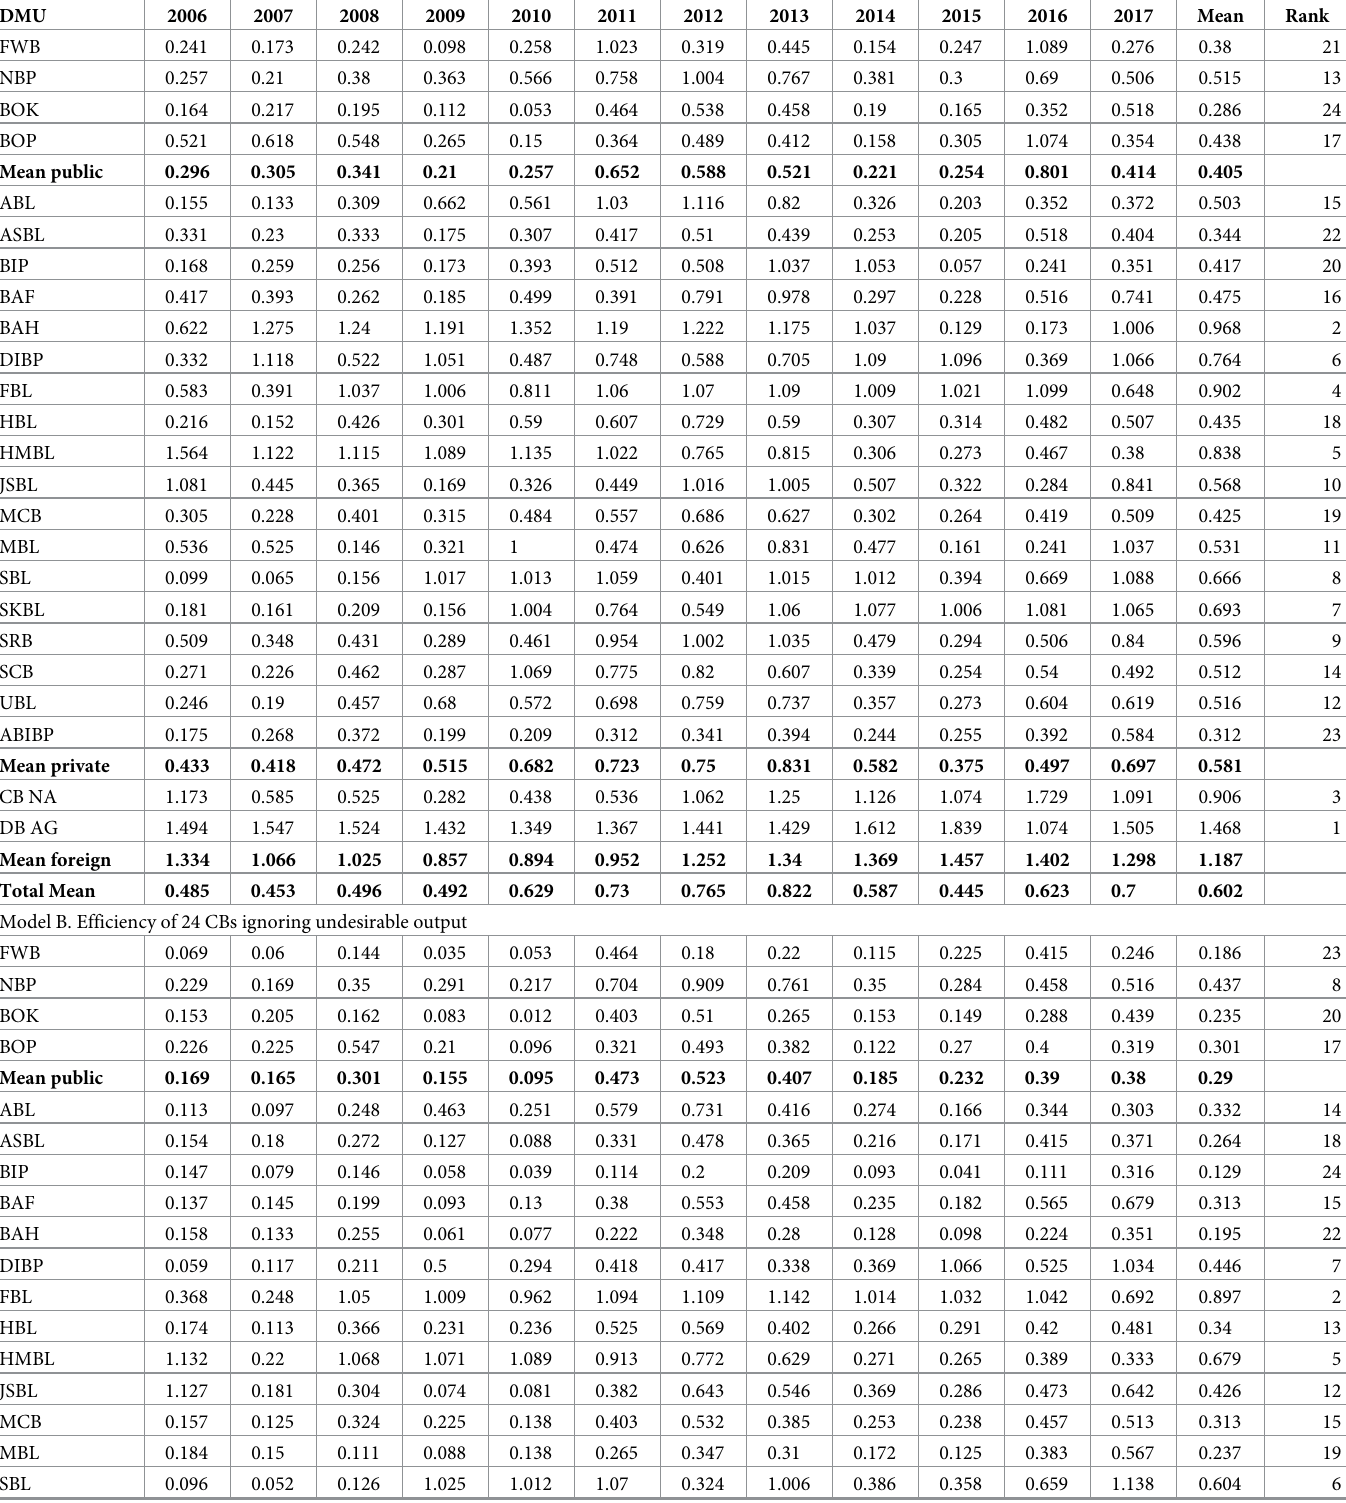
Table 5. Model B. Efficiency of 24 CBs considering the undesirable output.